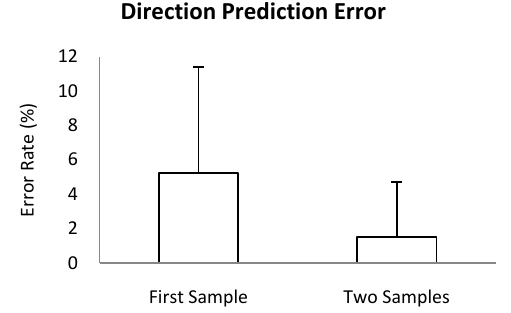
Figure 5. Direction prediction error rates for First Sample and Two Samples models.